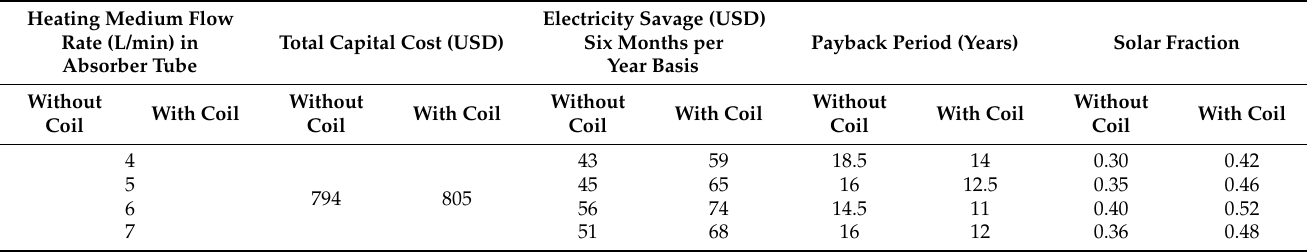
Figure 6. Monthly heating cost using electricity and solar concentrating unit having absorber without coil and with coil. Table 4. Comparative cost analysis of solar concentrating system having absorber tube with and without a coil under different flow rates of heating